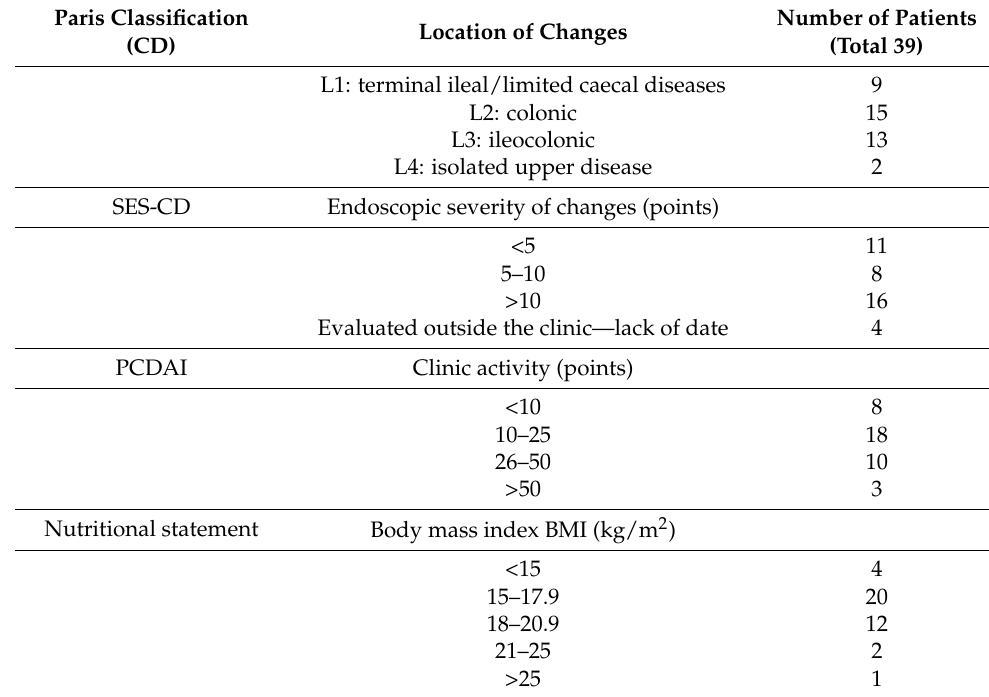
Table 3. Location, clinic, and endoscopic activity of changes at the time of diagnosis of CD.